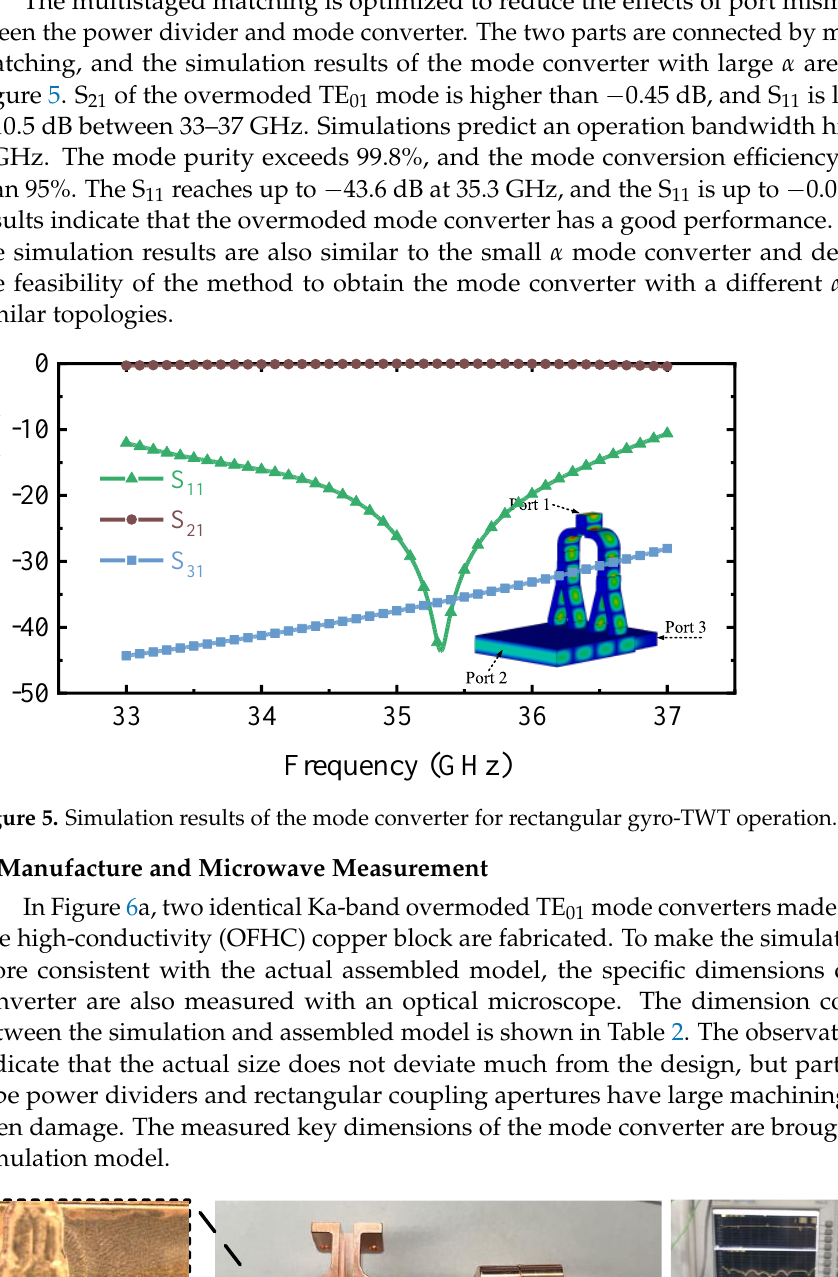
( b ) Figure 4. Simulated S-parameters of the ( a ) Small α mode converter. ( b ) Y-type power divider. After determining the position of the mode converter input port, a Y-type power di- vider is designed and simulated. As shown in Figure 4b, the S 21 is greater than −0 .45 dB, and the S 11 is lower than −3 0 dB between 33 – 37 GHz. The results indicate that the perfor-